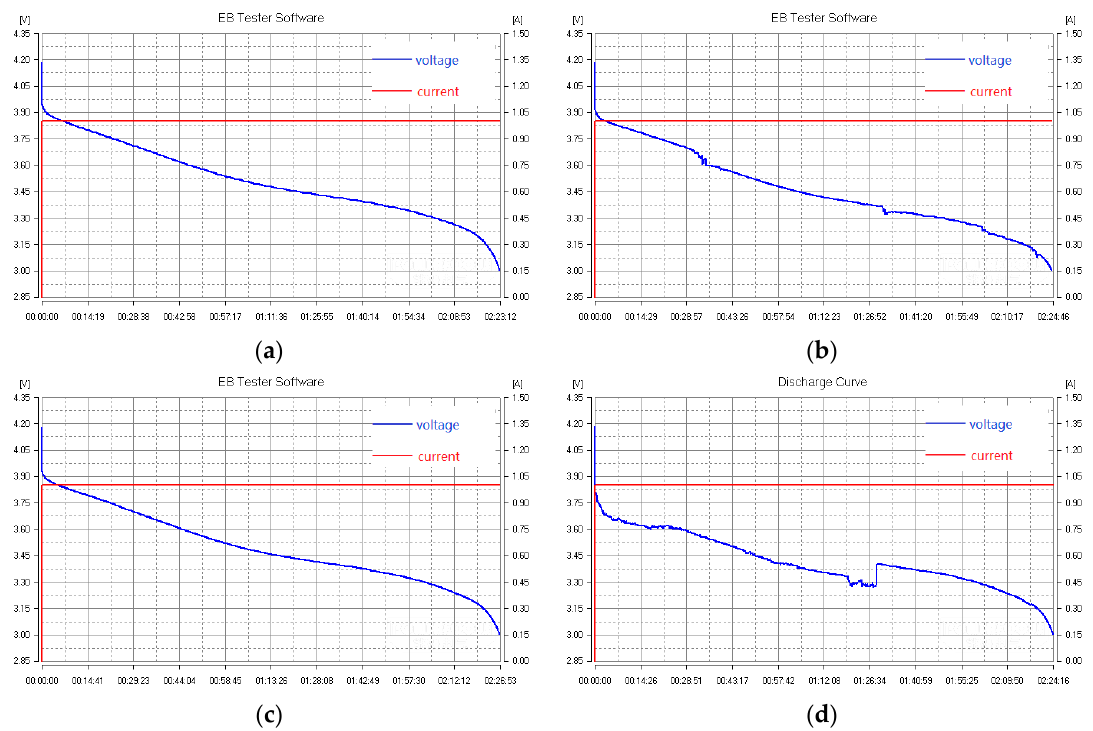
Figure 2. Voltage curve under 1A constant current discharge using batteries with different state of health (SOH). From ( a) –( d ), the SOH of the battery decreases in turn. ( a ) is the voltage vs. 1A-constant current curve of the battery with the best SOH, while ( d ) is of the lowest one.